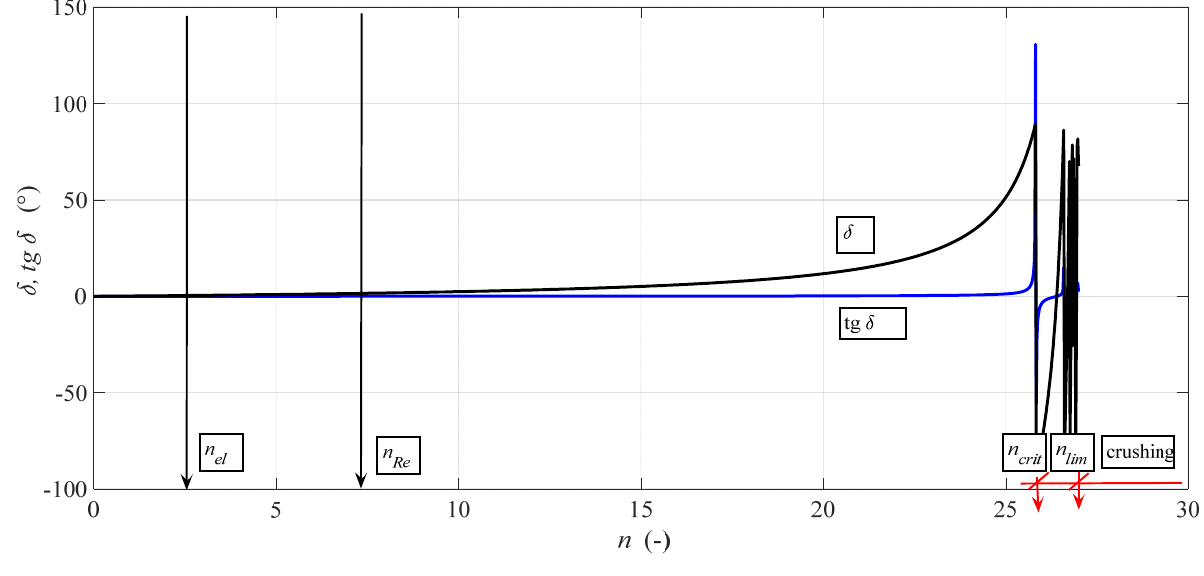
Figure 7. Angle of internal friction.